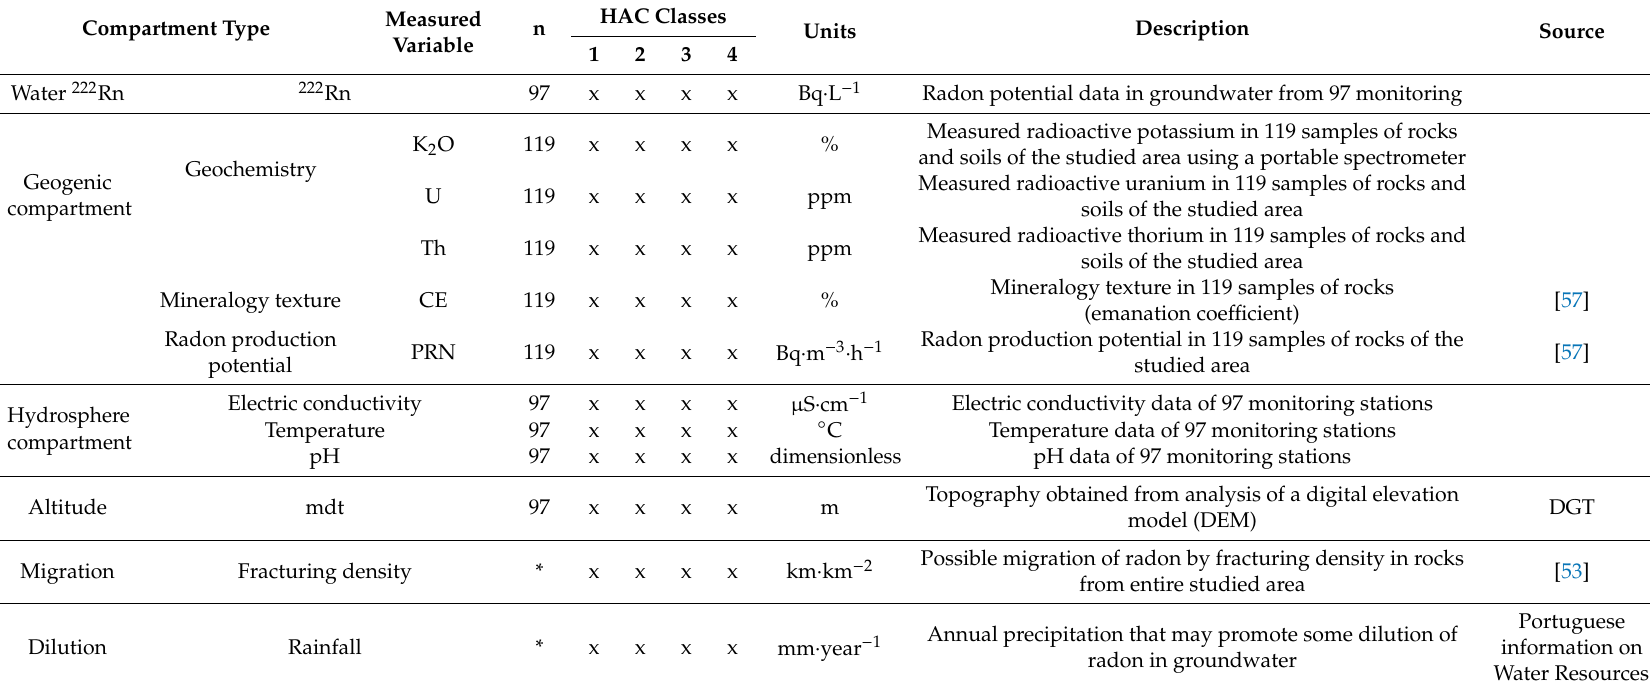
Table 1. Sources of information and list of measured variables used as a source data for partial least squares-path modeling (PLS-PM). This table contains the identification of variables, their measurements units, and description. The n values represent the number of sites used in the interpolation of variables that were measured solely at specific locations (see locations in Figure 1b) Websites was assessed in February 2017. Symbol description (institution names in